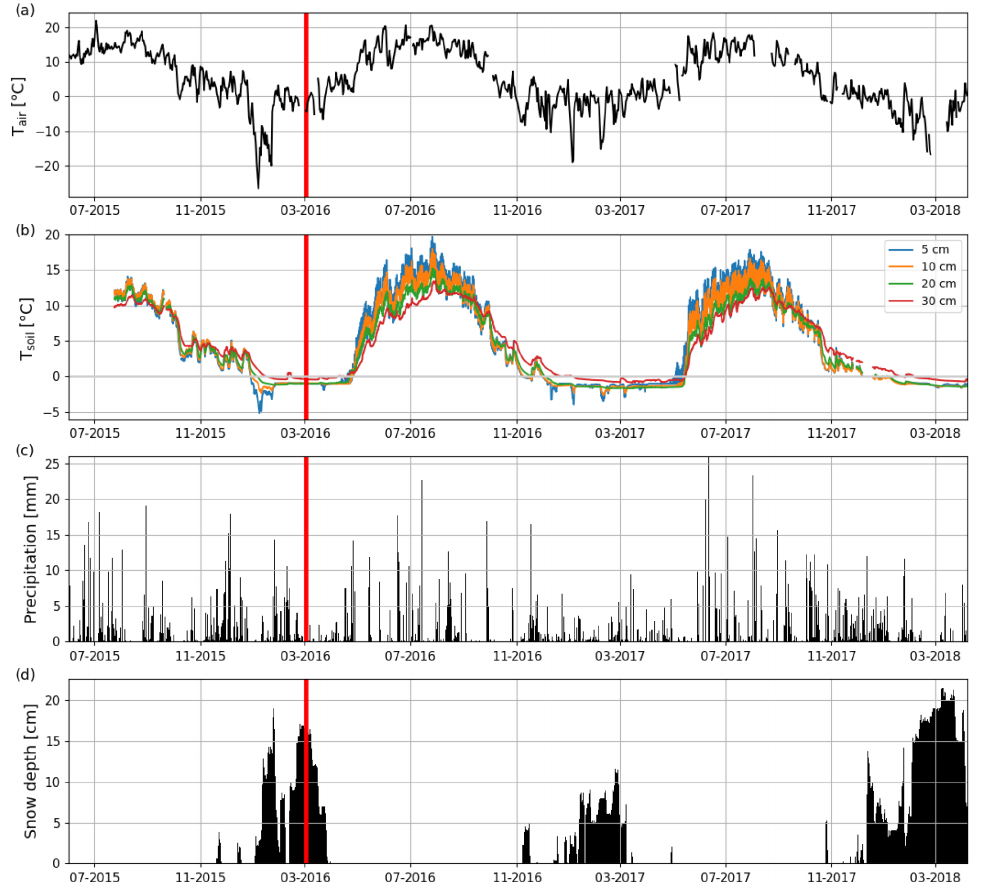
Figure 2. Time series of (a) daily mean air temperature ( T air ) and (b) hourly mean soil temperatures at 5, 10, 20, and 30cm depths ( T soil ) measured at Lettosuo, and (c) daily precipitation sum and (d) daily mean snow level recorded at the Jokioinen observatory (35km